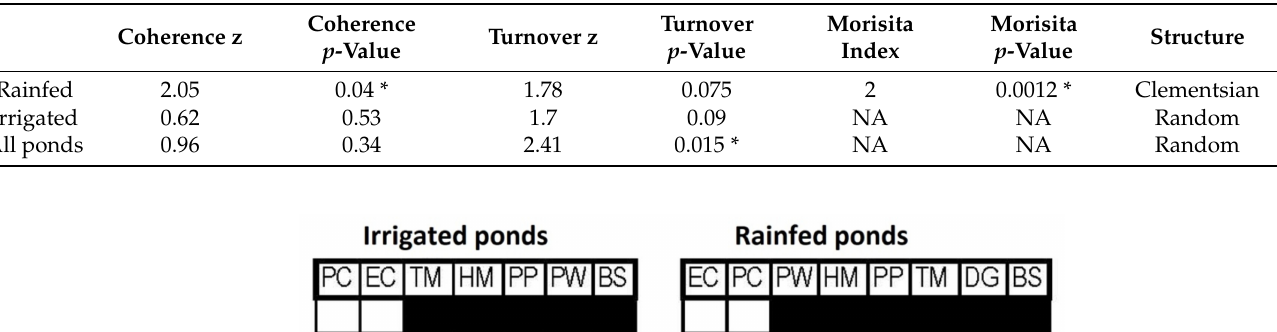
Table 2. Results of the Elements of Metacommunity Structure Analysis. * Significant under α = 0.05.